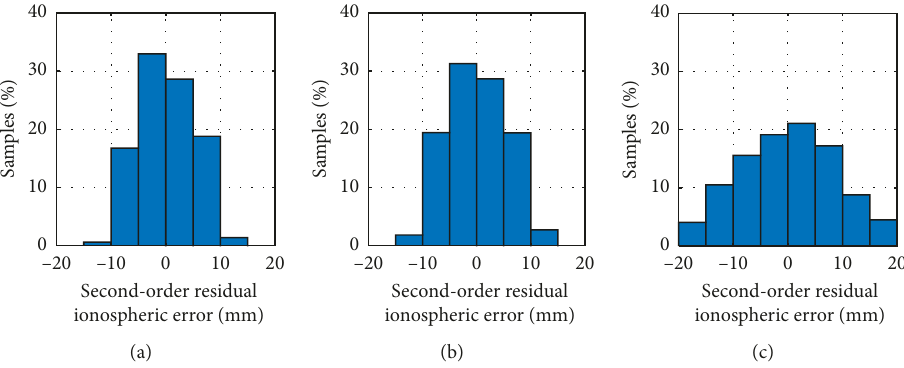
Figure 4: The statistic histograms of the second-order ionospheric correction residuals at 15km (a), 45km (b), and 90km